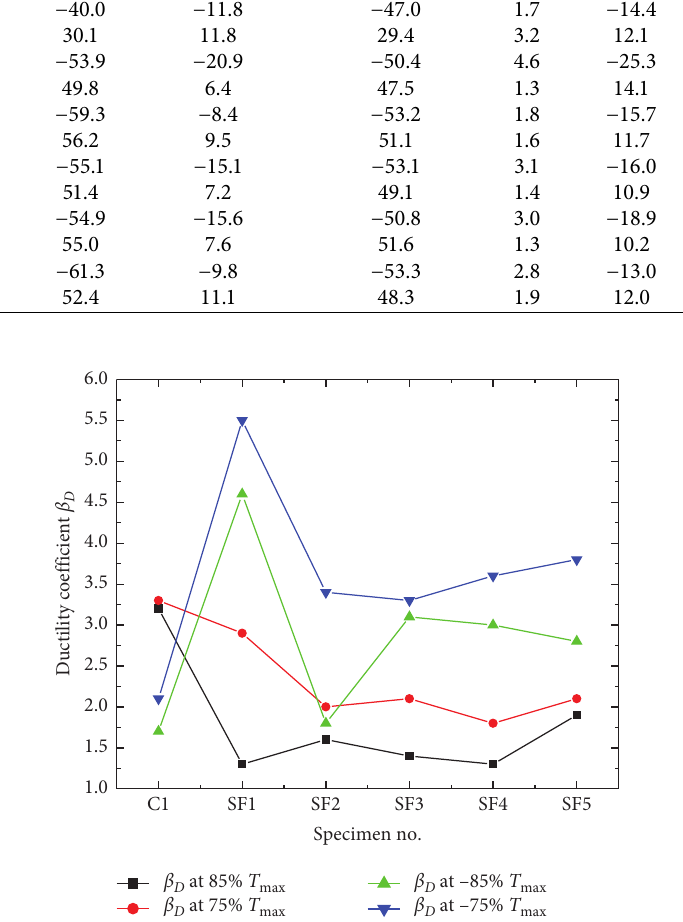
Figure 17: Ductility coefficient at θ